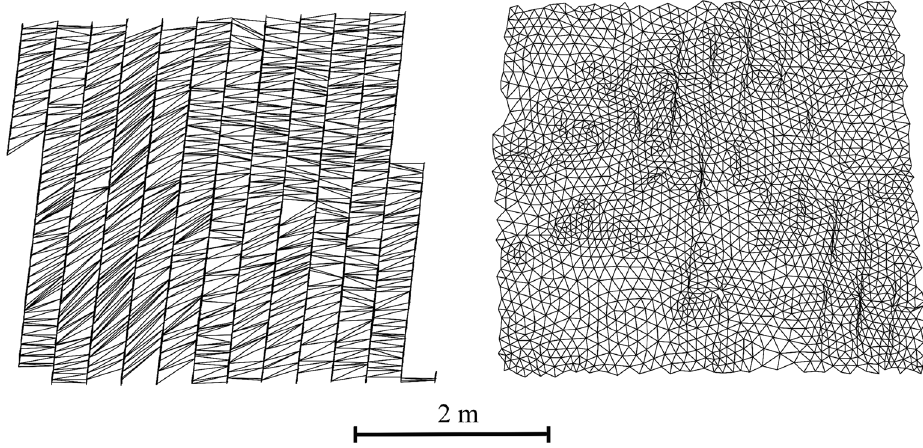
Fig. 9 Comparison of the chosen part of the mesh CS-BF before (left) and after (right) optimization